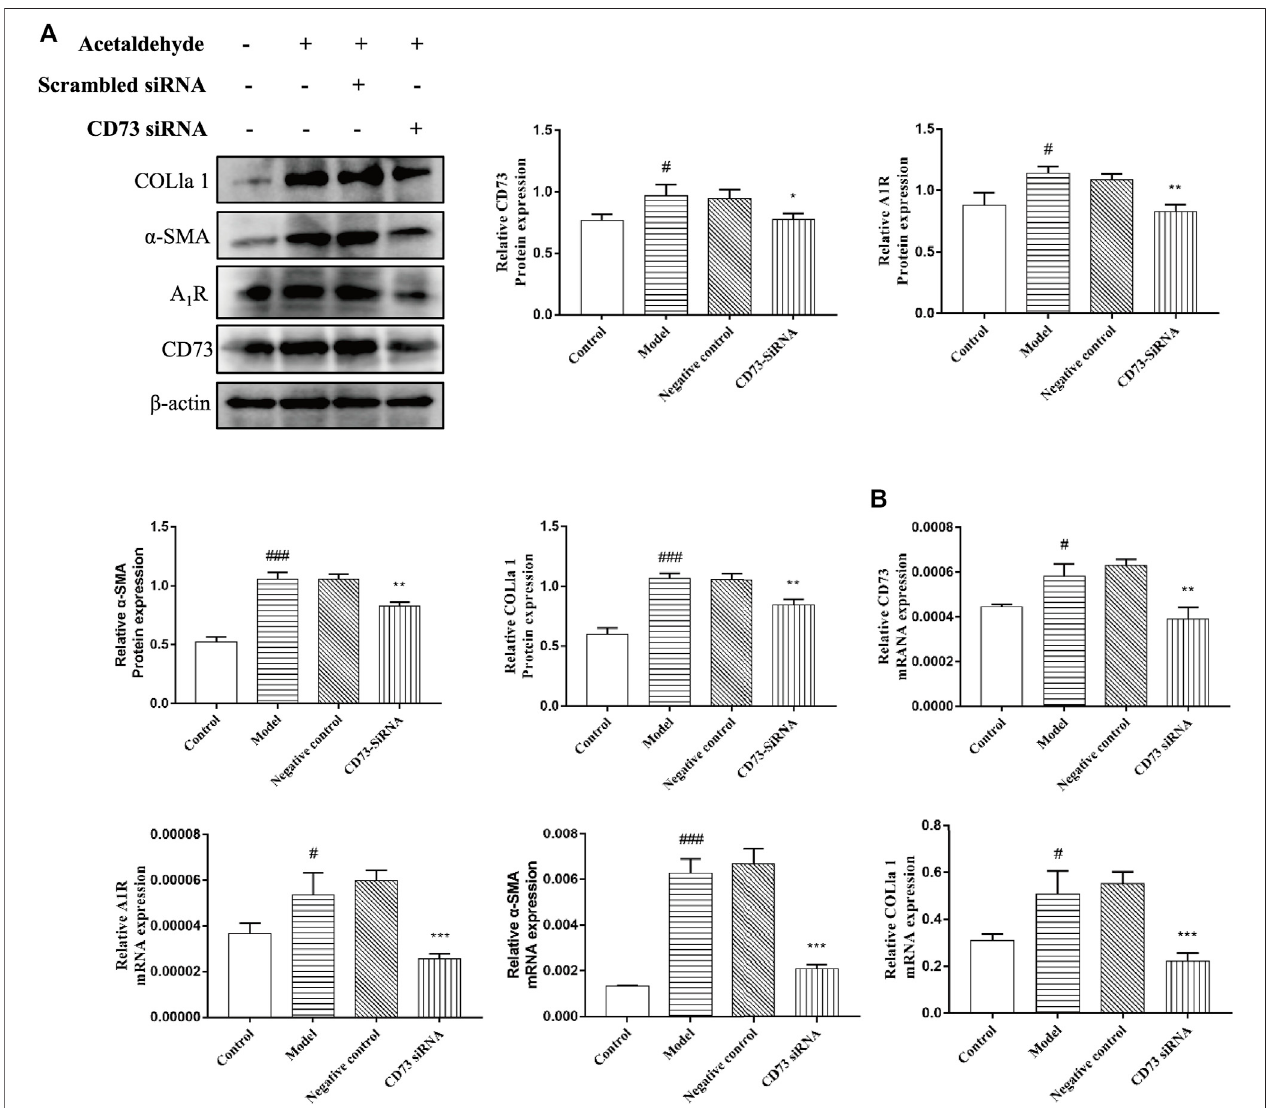
FIGURE 4 | Effect of silencing CD73 on HSC-T6 cell activation in acetaldehyde-induced HSC-T6 cell. (A) The protein levels of CD73, A 1 R, α -SMA and COL1a1 in HSC-T6cell. (B)